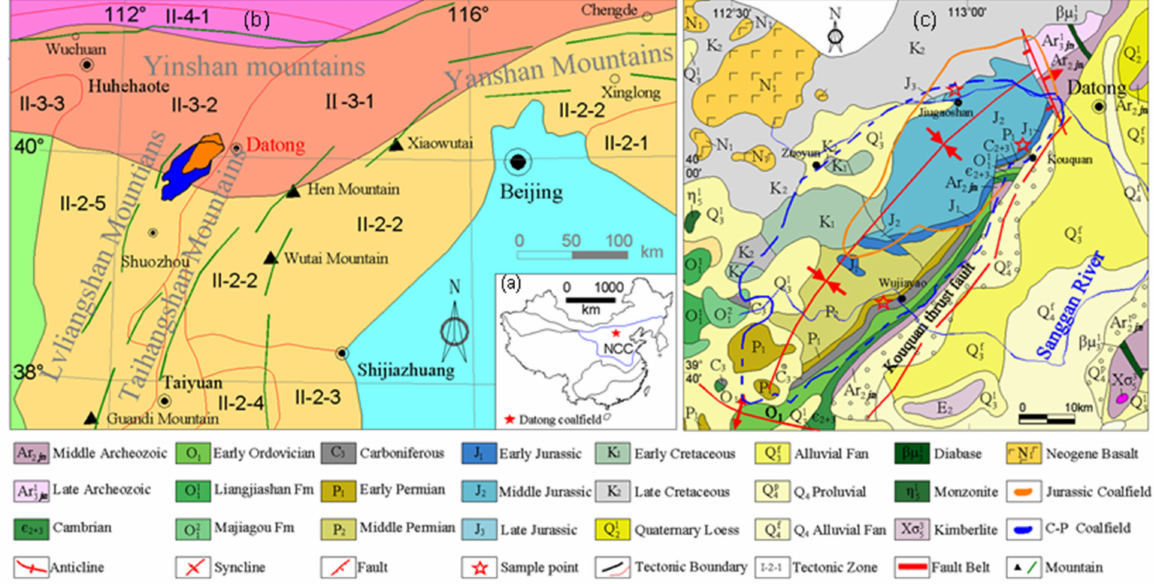
Figure 1. ( a ) Inset of the North China Craton in China; ( b ) Schematic geological map of northern NCC (revised from Pan et al. [28]); ( c ) Detailed geological map of the Datong coalfield; Note for ( b ): II-2-Jin- Ji landmass; II-2-2-Zunhua-Wutai-Taihang mountain lava arc; II-2-5-Lvliang carbonate platform; II-3- Daqing Mountain-North Hebei paleo-arc basin system; II-3-1-Heng mountain-Chengde-Jianping lava arc; II-3-2-Daqingshan-Liangcheng continental marginal basin; II-4-1-Lang Mountain-Yin